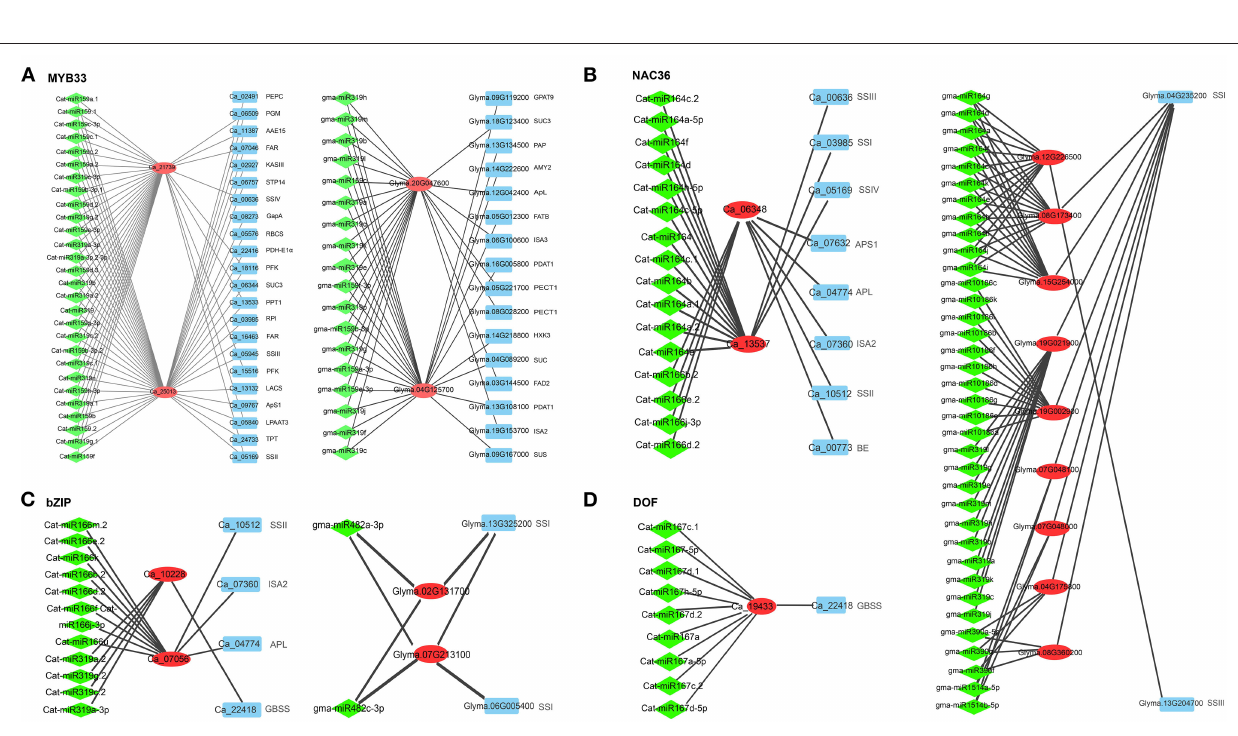
FIGURE 4 | The regulation networks of soybean and chickpea genes (red) homologous to four transcription factors AtMYB33 in Arabidopsis (A) , NAC36 (B) , bZIP (C) , and DOF (D) . Homologous genes and miRNAs are, respectively, marked by red and cyan colors, while lipid- and starch metabolism-related genes are marked by blue